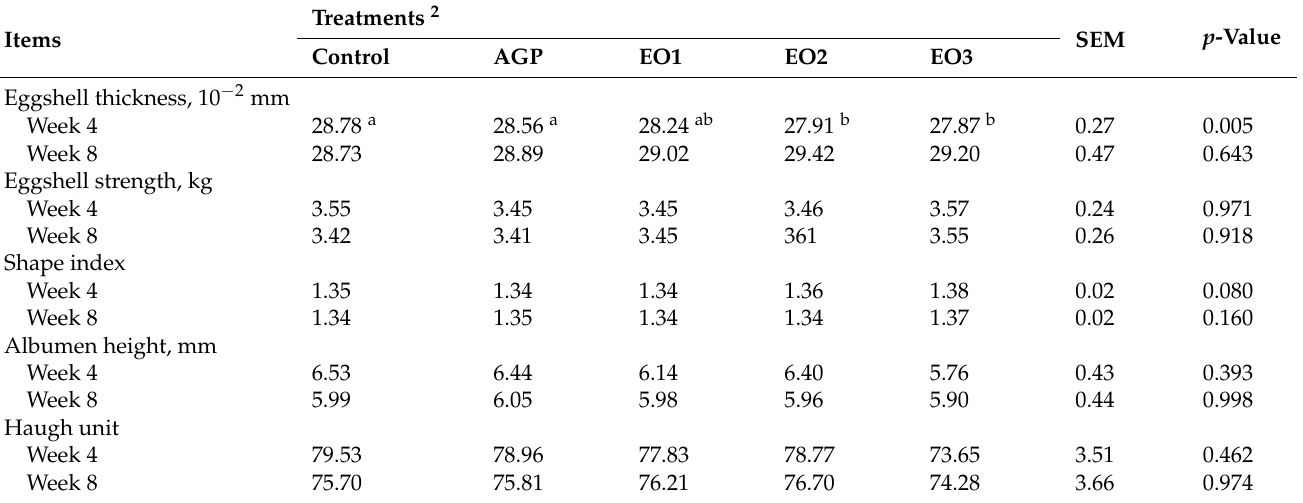
Table 3. Effects of dietary supplementation with oregano essential oil on egg quality of laying hens 1